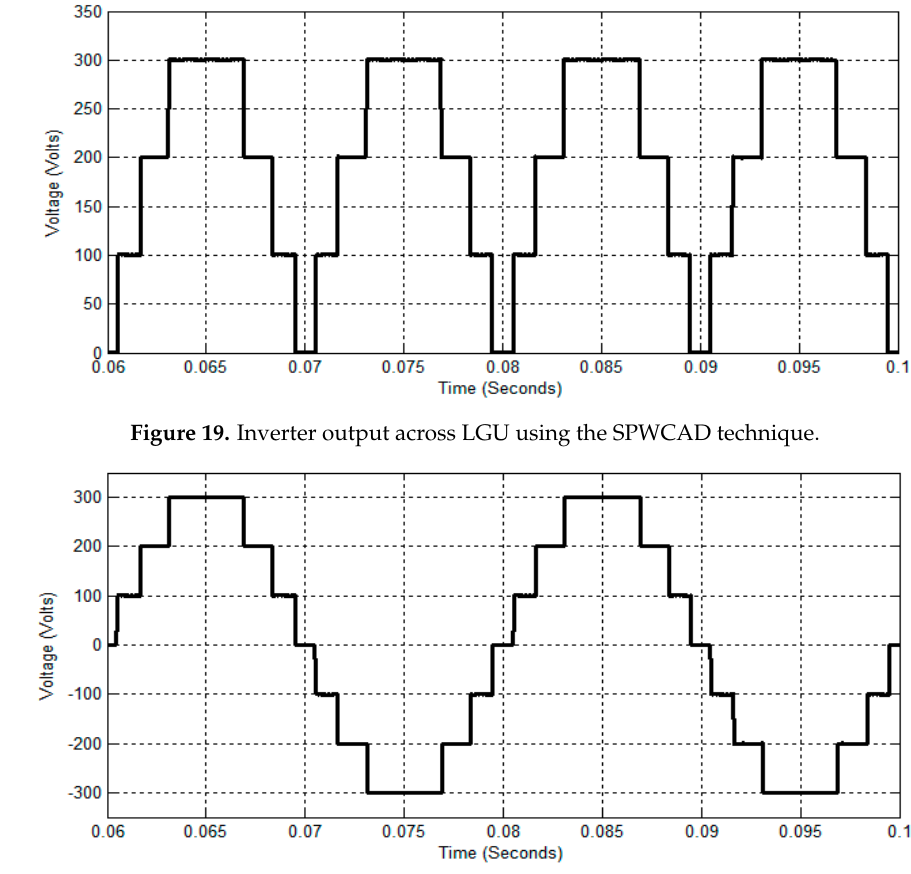
Figure 20. TLBDCLCHB inverter output using the SPWCAD technique.